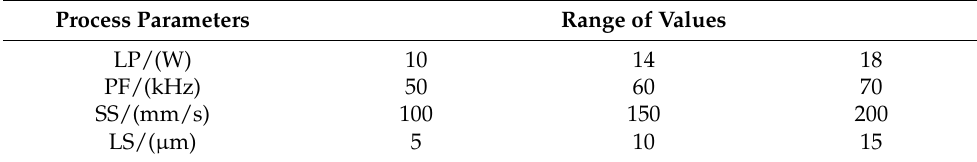
Table 4. Process parameters of plane scanning.